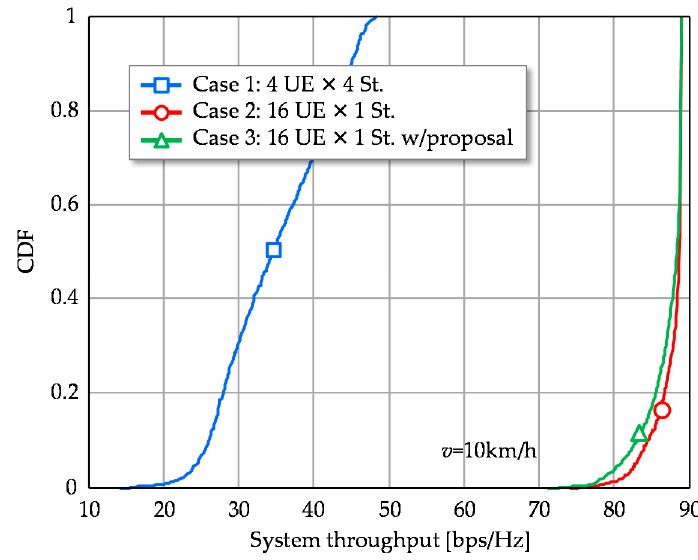
Figure 8. CDFs of System throughput.